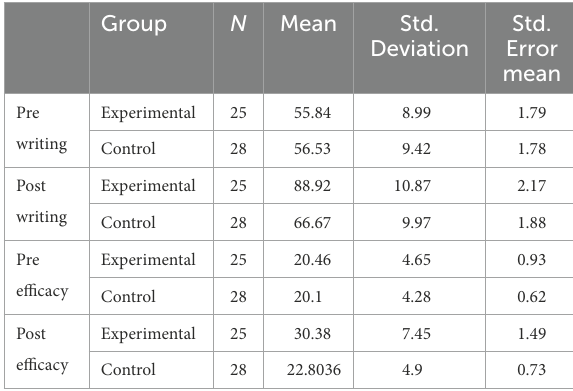
TABLE 2 Descriptive statistics for pre- and post-tests scores.